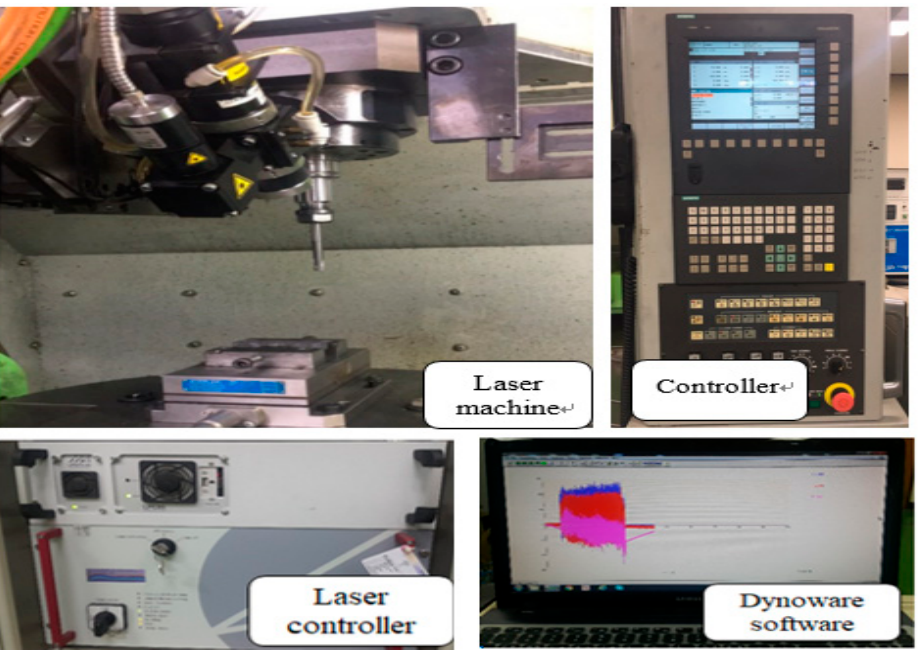
Figure 6. The experimental